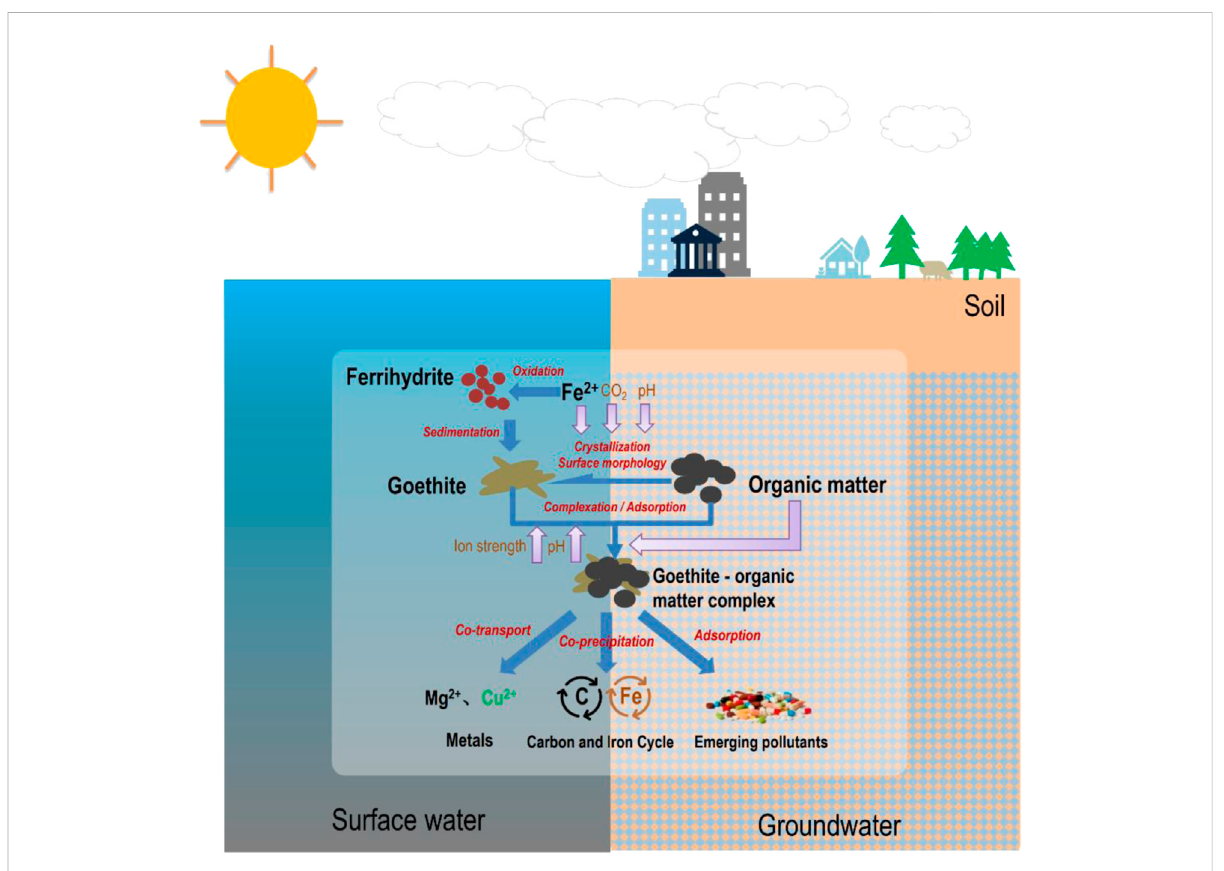
FIGURE 1 In fl uencing factors and environmental effects of interactions between goethite and OM. The crystallization process and surface properties of goethiteareresponsibleforitsabilitytoadsorborganicmatter,andtheinteractionsarecontrolledbyexternalfactorssuchaspH,CO 2 ,ionicstrength, and internal factors of their concentrations and properties. The interactions between goethite and OM have a critical environmental impact on the